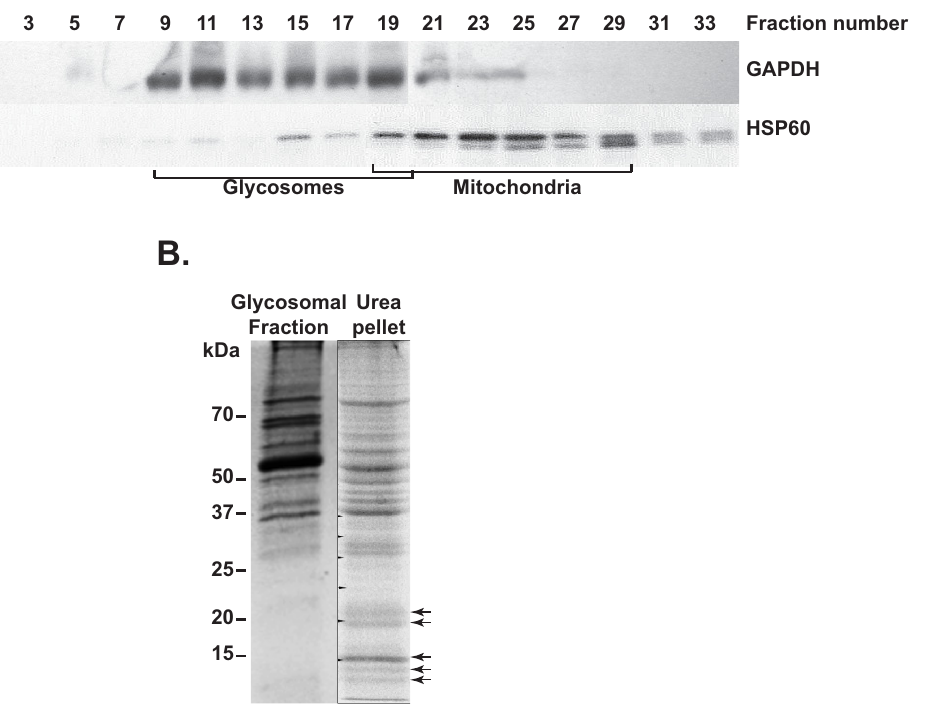
Figure 1. Purification of glycosomal membrane-enriched fractions from L. tarentolae . A . Western blot analysis of the different L. tarentolae fractions obtained after density gradient centrifugation. Equal volumes of only the odd-numbered fractions were loaded for analysis. Antibodies used for detection are indicated next to the western blot panels. Mitochondrial 19–29 and glycosomal 9–19 density gradient fractions are indicated. B . SDS-PAGE gel stained with Coomassie brilliant blue, showing protein bands from intact glycosomes (glycosomal fraction, and from the glycosomal membrane-enriched pellet (urea pellet). Arrows indicate enriched proteins in the urea-treated glycosomal membrane